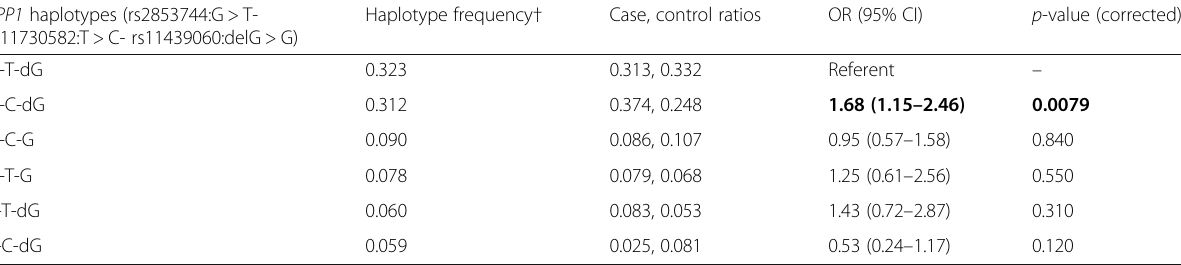
Table 3 Association of urolithiasis risk with of SPP1 genetic variants considering haplotype analysis